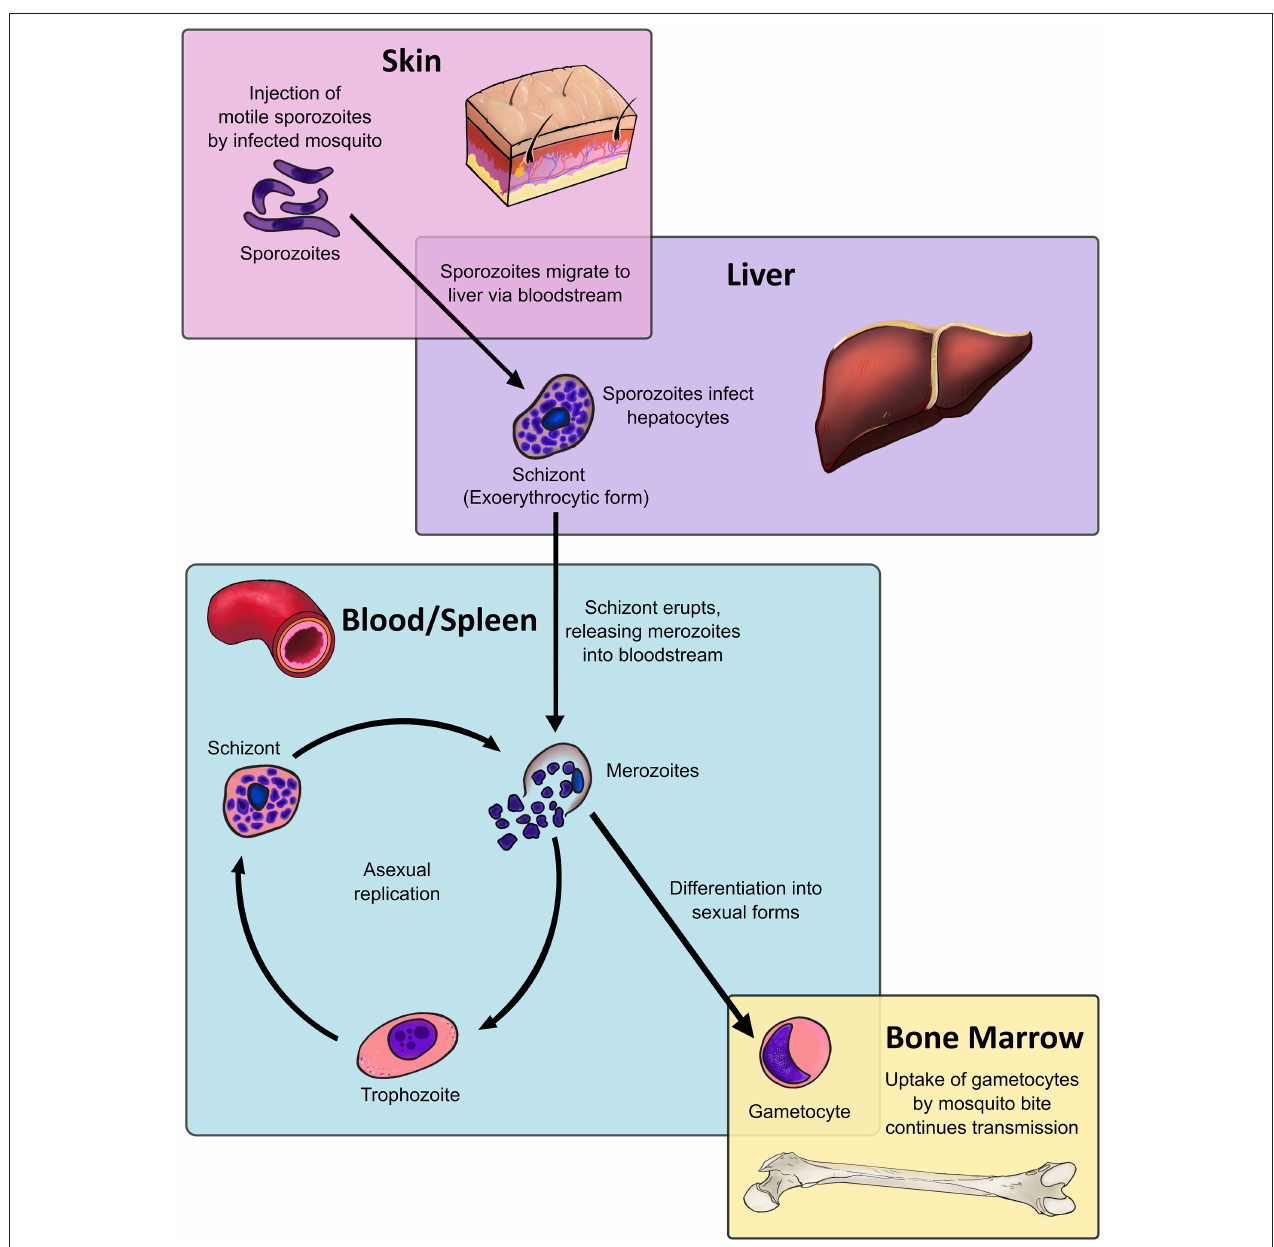
FIGURE 1 | Dendritic cells, located throughout the body at various stages of maturity, interact with all stages of the malaria parasite life cycle within the human host. The Plasmodium life cycle encompasses multiple life stages across a range of tissues. The asexual life cycle in the human host begins when mosquitoes inject sporozoites, the highly motile infectious life stage, into the host’s skin. The sporozoite migrates to the liver, where it traverses multiple host cells before entering into an exoerythrocytic form. The exoerythrocytic form matures into a multinucleate schizont, which releases merozoites into the bloodstream upon lysis. Merozoites infect host red blood cells and mature into intraerythrocytic life stages known as trophozoites, which are highly metabolically active. After DNA replication the trophozoite will become a blood-stage schizont, which will lyse and release daughter merozoites into the bloodstream, resuming the process. Instead of becoming trophozoites, a fraction of merozoites will instead differentiate into sexual stages known as gametocytes, which sequester in the bone marrow. Only at the end of their maturation process do gametocytes re-enter the bloodstream, where they are taken up by mosquito bite to commence sexual replication in the mosquito host and continue the cycle.